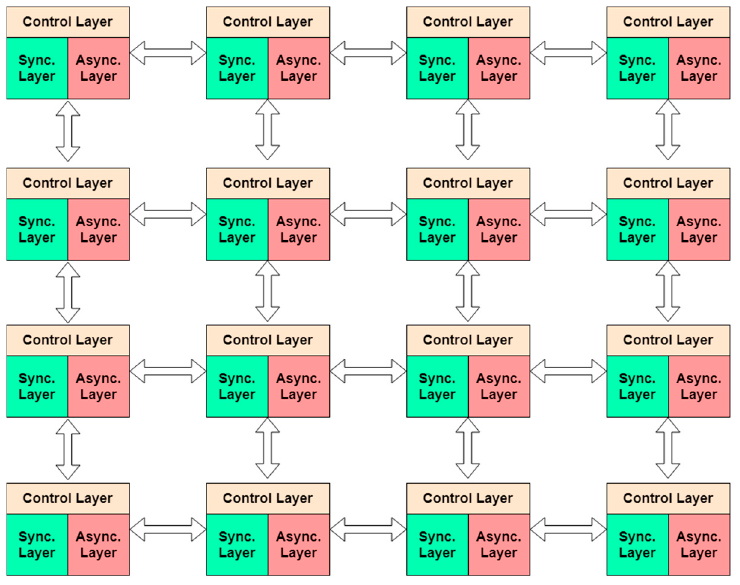
Figure 1. The proposed energy efficient double data layer synchronous-asynchronous circuit-switched NoC.